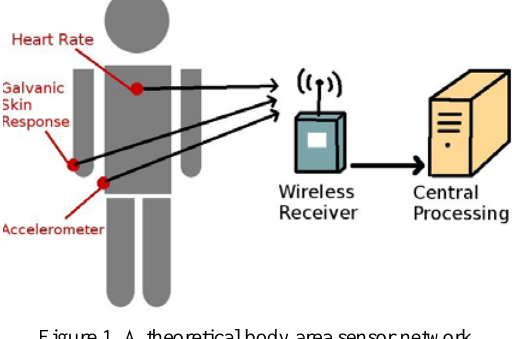
Figure 1. A theoretical body area sensor